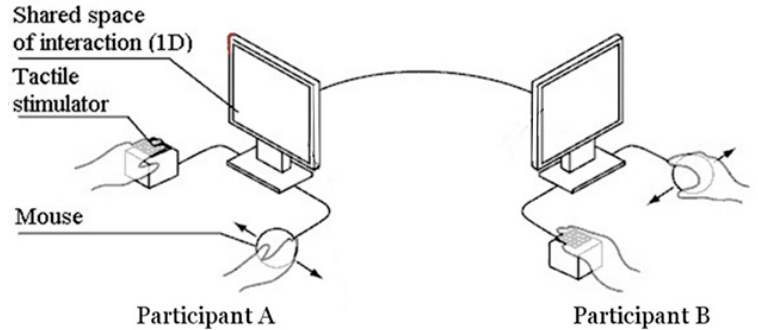
Figure 1. Experimental setup. Participants are physically separated and can only interact with each other through a minimal human-computer interface. They can move a virtual avatar with their mouse cursor with one hand and with the other they can feel an all-or-nothing stimulation whenever their avatar overlaps with an object in the shared virtual space (modified from Lenay and Stewart [53]). Crucially, the moving object is “attached” to the other person’s avatar, so that they have identical